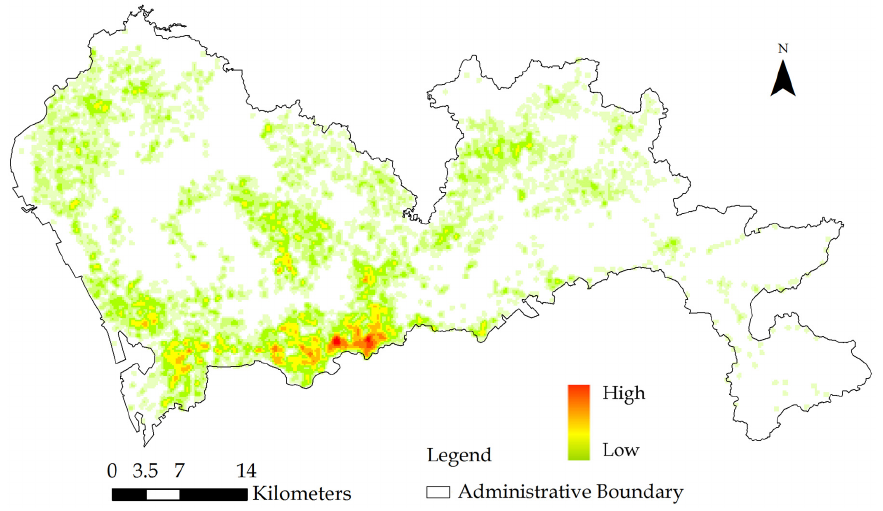
Figure 3. Cell phone tower spatial kernel density. Due to a dataset provider requirement, the point-based cell phone tower spatial distribution cannot be shown. The administrative boundary of Shenzhen is vectorized into shape-file according to the whitepaper of the Urban Planning, Land & Resources Commission of Shenzhen Municipality [59].